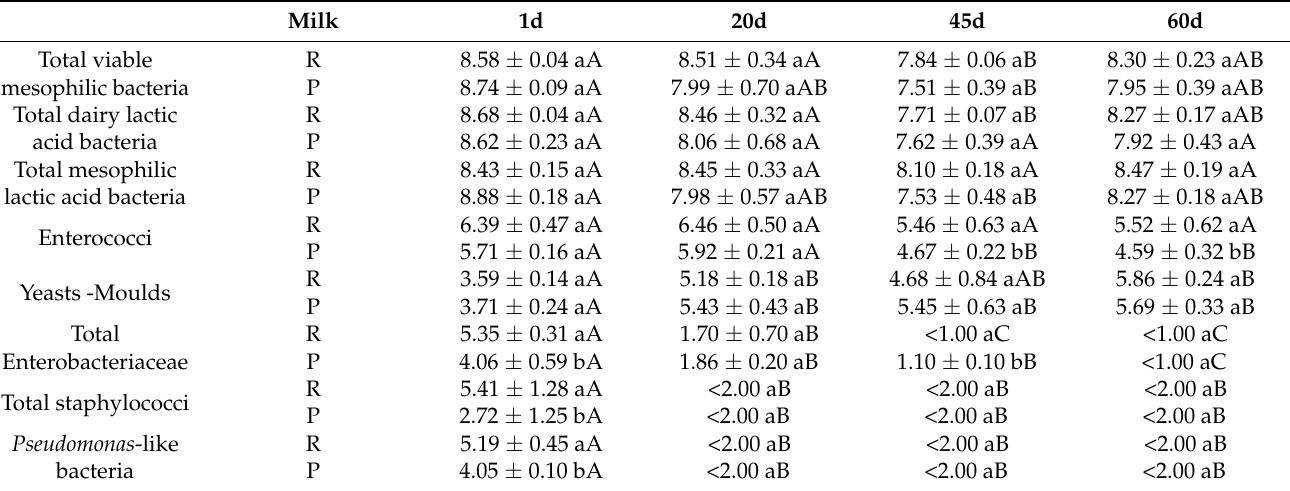
Table 1. Microbial characteristics (log CFU/g) of hard Xinotyri cheese made from raw (R) or pasteur- ized (P) milk, during ripening and storage (i) .